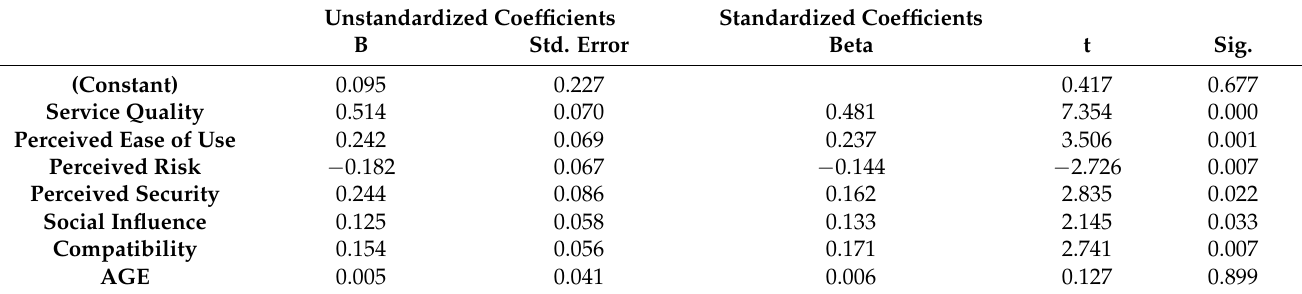
Table 7. Results of the regression